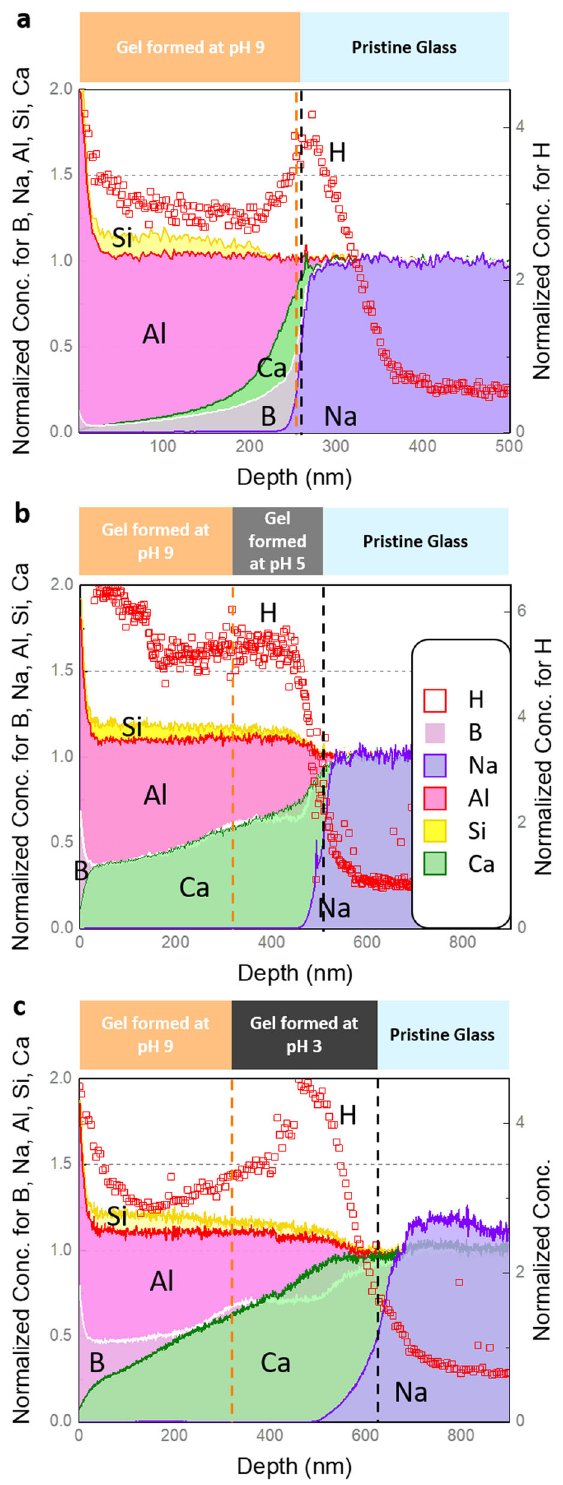
Fig. 4 Effect of a decrease in pH on ISG samples altered for 6 yr at pH 9. Elemental ToF-SIMS pro fi les of glass cations and H. a Before the pH swap. b After a 35-day immersion at pH 3. c Same as b but for the re-corrosion stage at pH 5. For b and c plots the orange dotted line indicates the position of the pristine glass surface before the pH swap. Therefore the gel located in between the orange and the black lines was formed during the stage of acid